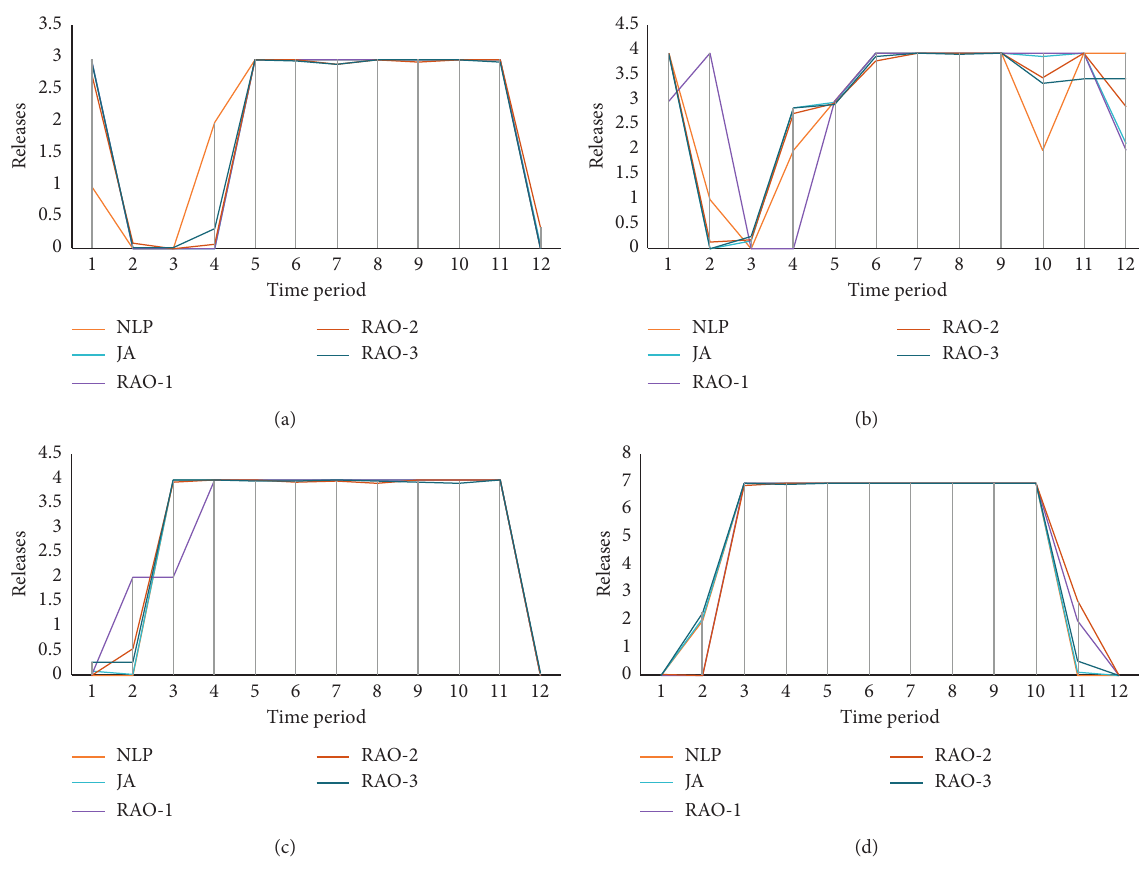
Figure 3: Release pattern for the DFRO system problem obtained through Rao algorithms. (a) Reservoir 1. (b) Reservoir 2. (c) Reservoir 3. (d) Reservoir 4. Table 5: The benchmark models and the proposed new algorithm of the current research performance for the DFRO system problem.